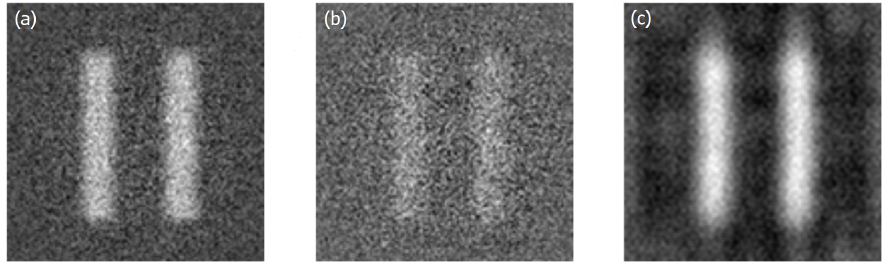
Figure 6. ( a ) double-slit image reconstruction obtained by correlations measurements, considering N = 6000 frames and two detectors characterized by a 128 × 128 and a 10 × 10 pixel resolution; ( b ) the standard reconstruction is repeated considering only the 10% of the available frames, chosen randomly; ( c ) compressive sensing reconstruction using the same dataset as in ( b ). While in the first case, the Pearson’s correlation coefficient is r red = 0.55; in the latter case, the coefficient is increased to r CS =